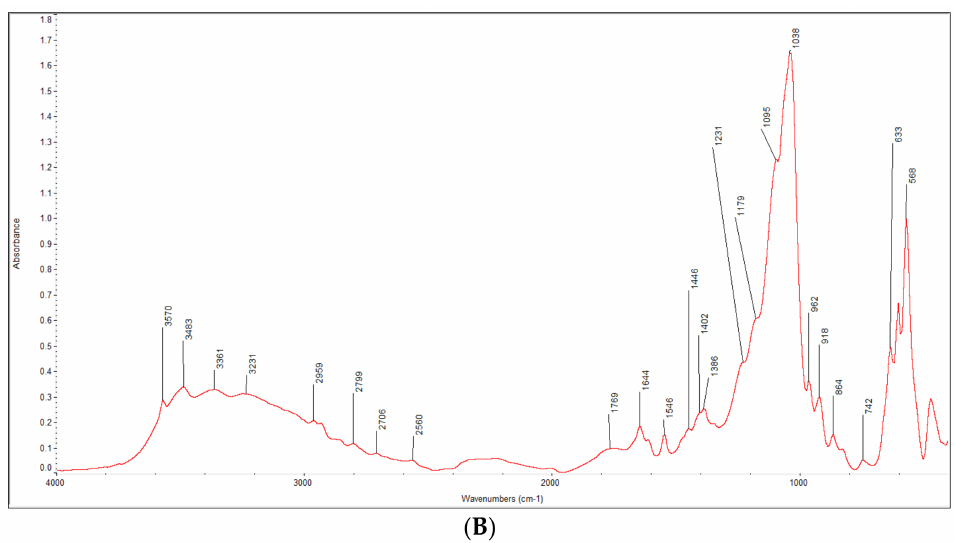
Figure 2. Fourier-transform infrared spectroscopy (FT-IR, Thermo Scientific, Waltham, MA, USA) spectrum of HA-AL 5 mM compound ( A ) and FTIR spectrum of 1:1 alendronate-hydroxyapatite mixture ( B ).